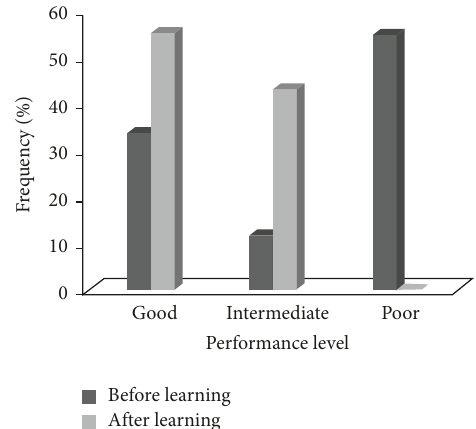
Figure 2: The total mean score of the midwives’ skills in problem- solving following electronic continuing medical education com- pared with before that.